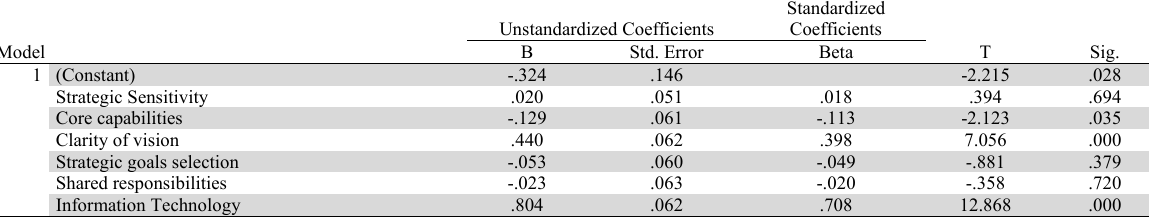
Table 3 indicates that three independent variables (core capabilities, clarity of vision, strategic goals selection) have a statis- tically significant impact at (a ≤ 0.05) level on employee performance in commercial banks in Jordan. The values of Beta ( β ) verify these results, in addition to T calculated